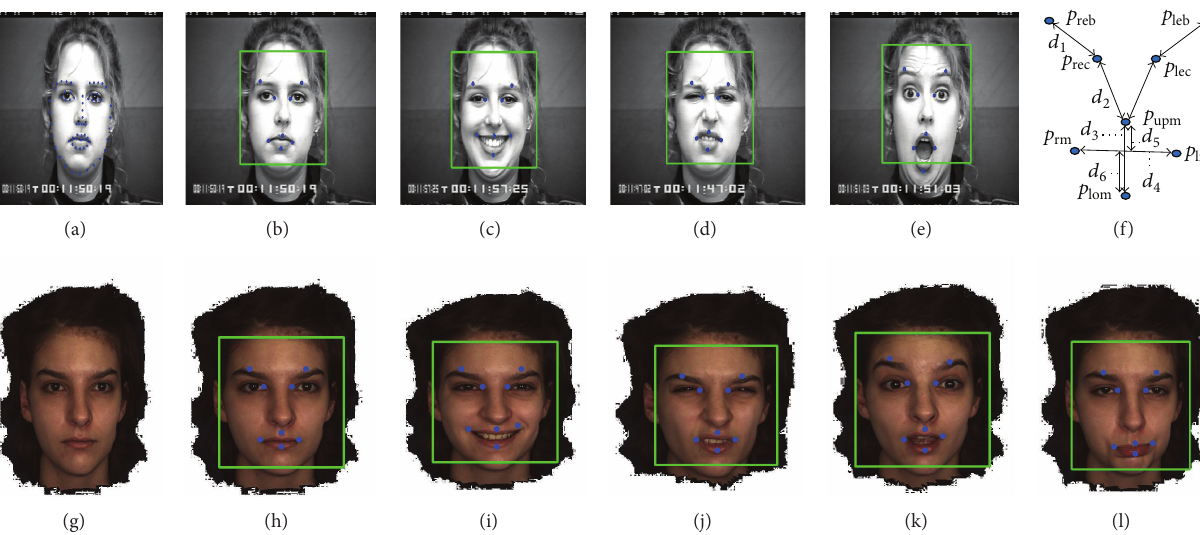
Figure 2: Face detection along with selected facial points and extracted features. (a) Human face in neutral expression overlaid with 68 fiducial facial points [13]. (b, h) The detected face with the selected eight facial points. (c, i) Human face in happy expression. (d, j) Human face in disgust expression. (e, k) Human face in surprise expression. (f) The six geometrical features; 𝑑 1 and 𝑑 2 are the average of two mirrored values on the left and right sides of the face. (l) Human face in sadness expression. Images (a)–(e) are from Cohn-Kanade database, Jeffrey Cohn. And the images (g)–(l) are samples from